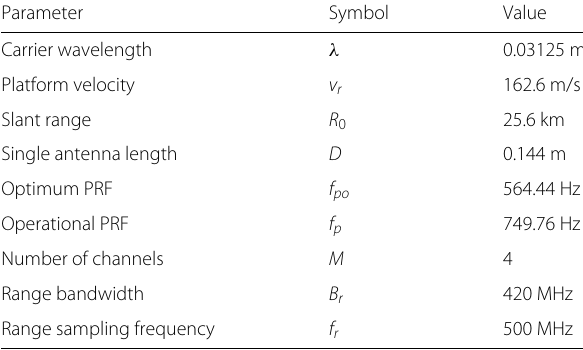
Table 3 Main parameters of airborne azimuth multichannel SAR